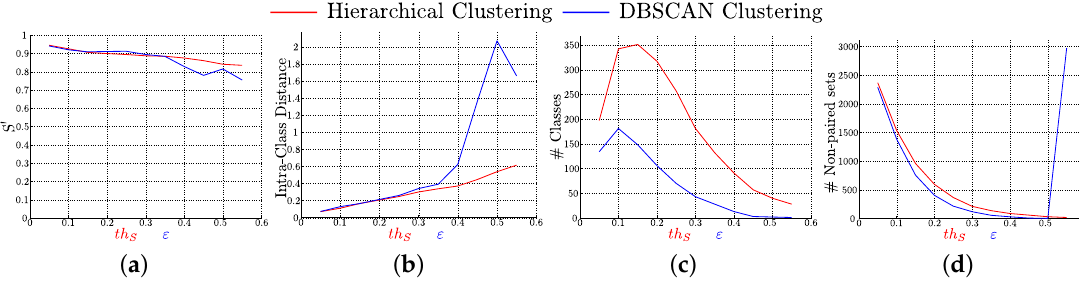
Figure 5. Comparison of the clustering results for both studied methods: Hierarchical Clustering and DBSCAN Clustering. Evaluation of the normalized inverse pixel deviation ( a ); intra-class distance ( b ); number of created classes ( c ) and number of non paired classes ( d ) for both Hierarchical Clustering ( red ) and DBSCAN ( blue ) clustering. th S and ε are equivalent parameters for both clustering methods respectively. (Best seen in color).